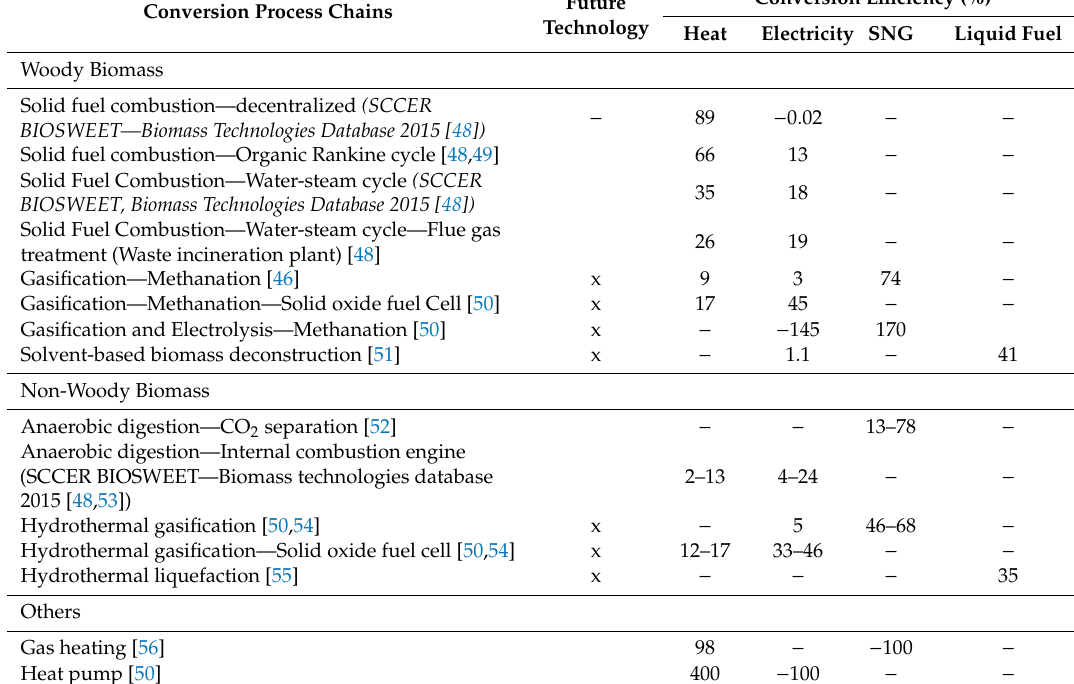
Table 3. Overview of the e ffi ciencies of the considered conversion paths in relation to the biomass on the type of biomass used. These are more precisely broken down in Figure